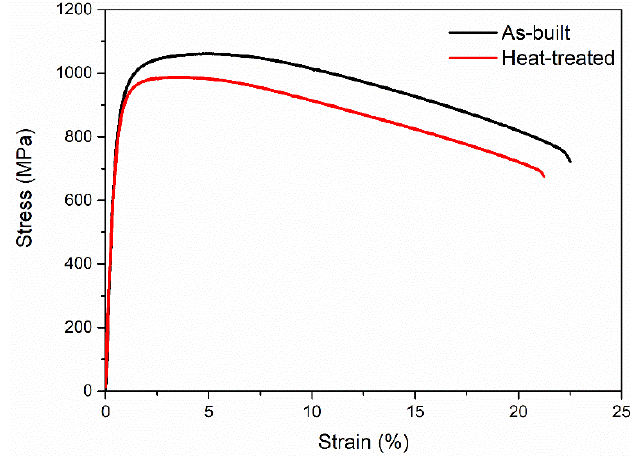
Figure 11. Engineering stress–strain curve of the as-built and heat-treated samples. Table 7. Tensile properties of the as-built and heat-treated samples.